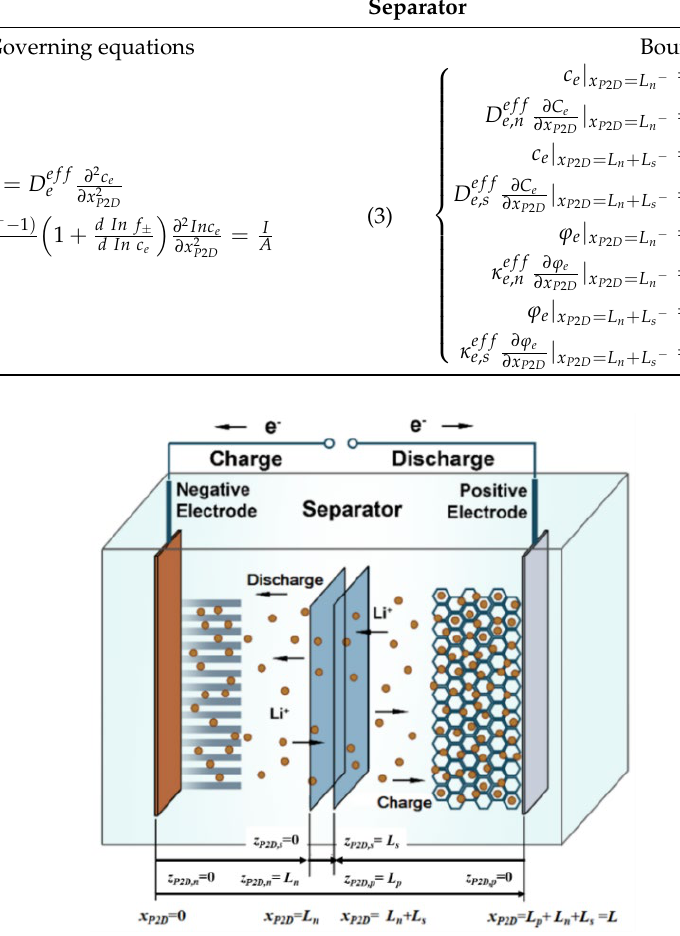
Figure 2. Charge transfer in the battery cell [23].